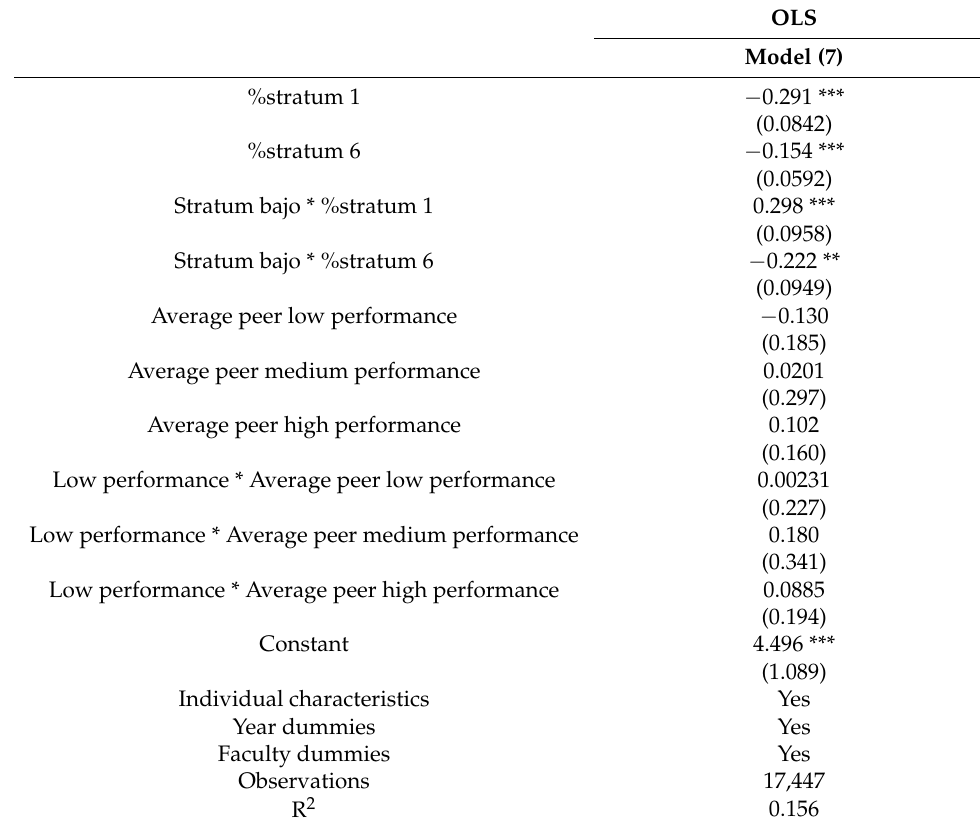
Table A8. Effects of heterogeneous peers according to student’s socioeconomic level in Communica- tion Skills